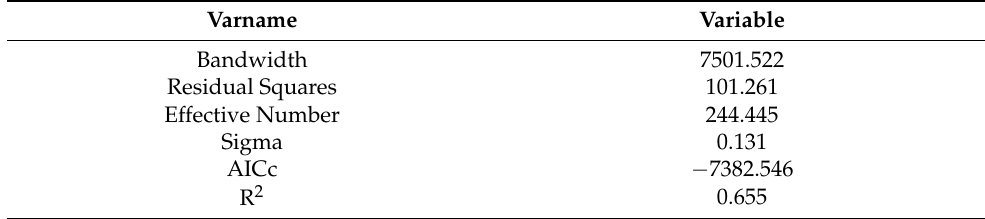
Table 8. Geographically weighted regression parameters.